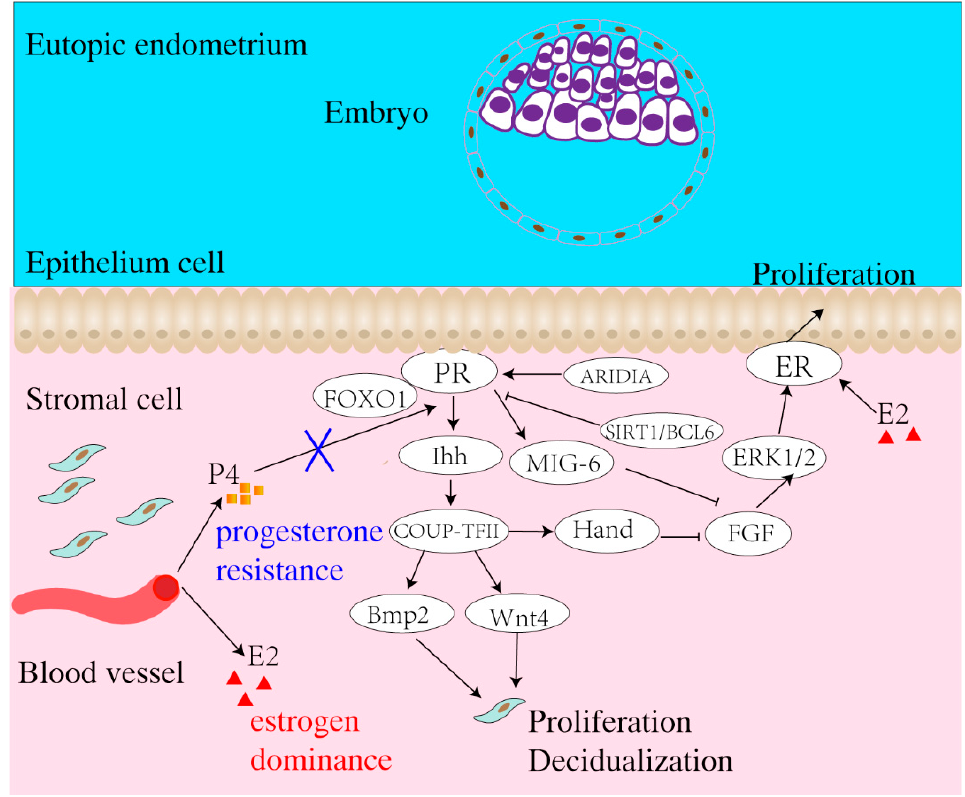
Figure 1. Schematic illustration of the mechanism of progesterone and estrogen signaling in the regulation of endometrial receptivity. In the normal endometrium, progesterone and estrogen signaling work together to inhibit epithelial proliferation and facilitate the transition to an embryo-receptive state during the window of implantation. Yet in EMS, the dysfunctions of progesterone and estrogen signaling bring about progesterone resistance and estrogen dominance. ARIDIA, AT-rich interacting domain protein 1A; BCL6, B-cell lymphoma 6; BMP2, bone morphogenetic protein 2; COUP-TFII, chicken ovalbumin upstream transcription factor II; E2, estrogen; ER, estrogen receptor; ERK, extracellular signal-regulated kinase; FGF, fibroblast growth factor; FOXO1, forkhead box O; HAND2, heart- and neural crest derivatives-expressed 2; IHH, Indian Hedgehog; MIG-6, mitogen-induced gene-6; P4, progesterone; PR, progesterone receptor; SIRT1, sirtuin1; Wnt4, wingless-related MMTV integration site4.